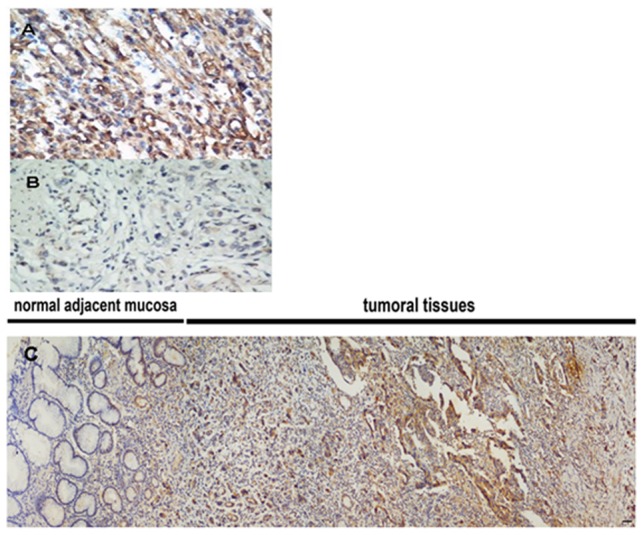
Representative examples of Beclin1 expression.High Beclin 1 (A) and low Beclin 1 (B) expression in human gastric cancer specimens (×400), Beclin 1 positive staining in the tumor and negative staining in normal adjacent mucosa(×20) (C).